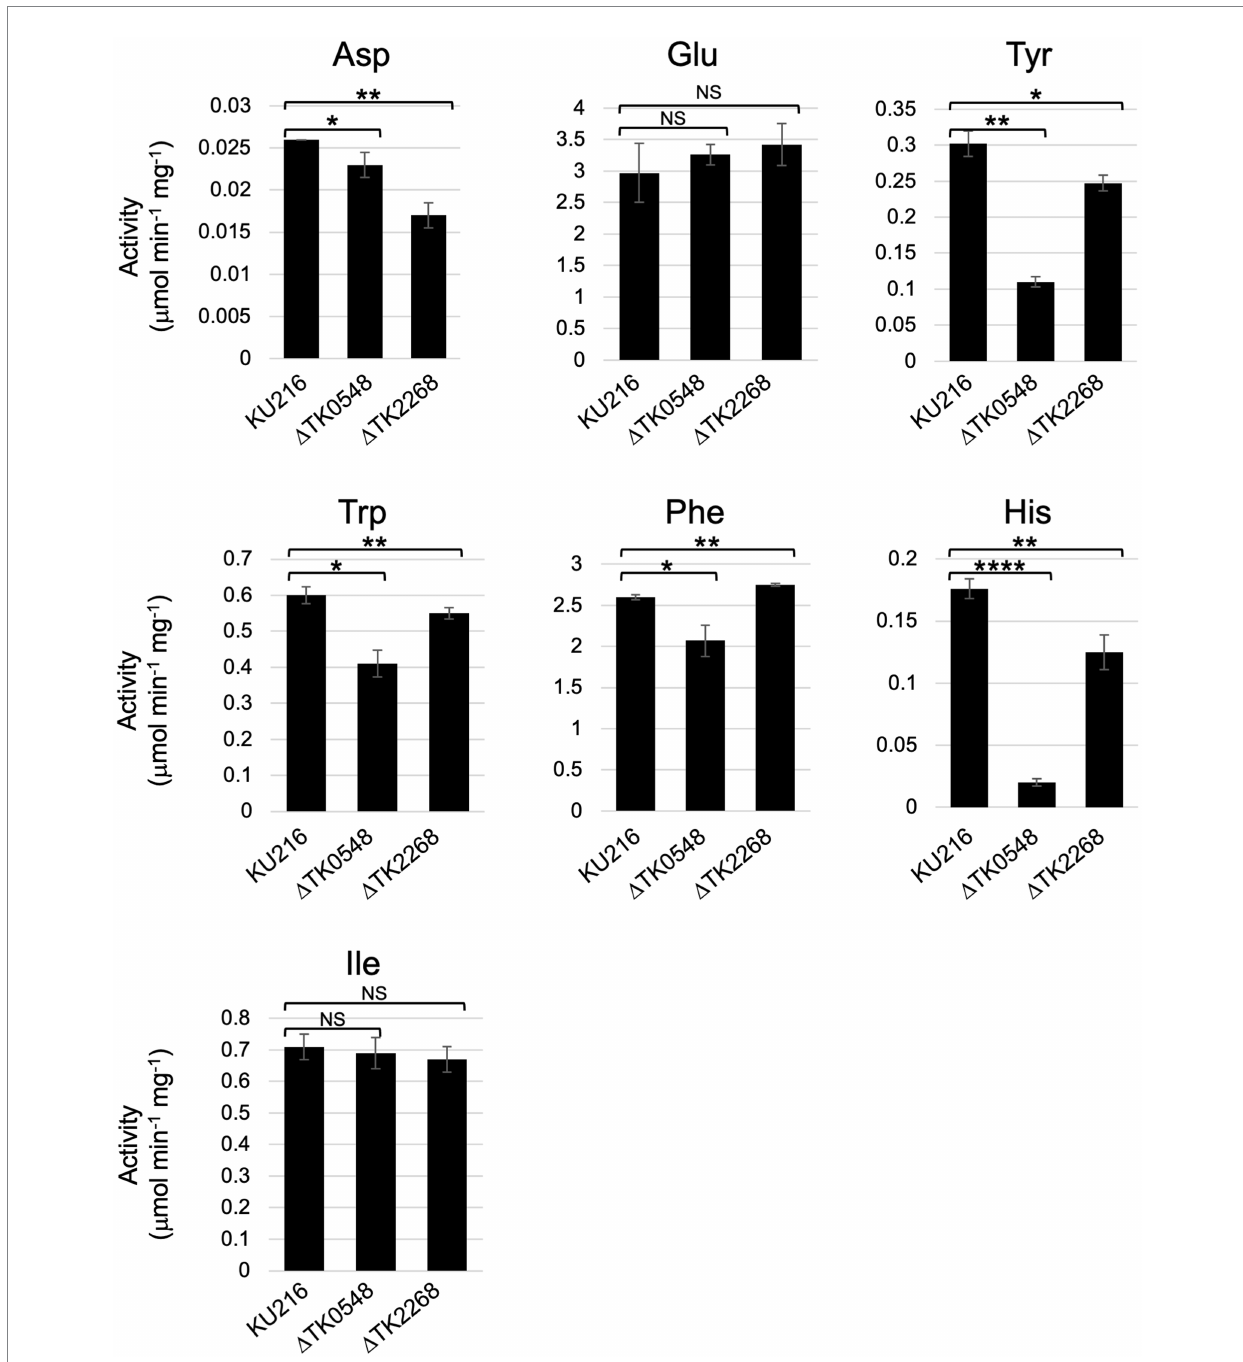
FIGURE 7 Aminotransferase activity in T. kodakarensis cell extracts. Cell extracts were incubated with different amino acids and 2-oxoglutarate, or pyruvate (for Glu and Asp), at 80 ° C for various periods of time. Activity was calculated based on the generation of Glu or Ala. Amino donors and acceptors were added at a concentration of 10 mM (Tyr: 6 mM). 0.01 < p < 0.05*; 0.001 < p < 0.01**; 0.0001 < p < 0.001***; p < 0.0001****; not significant: NS.